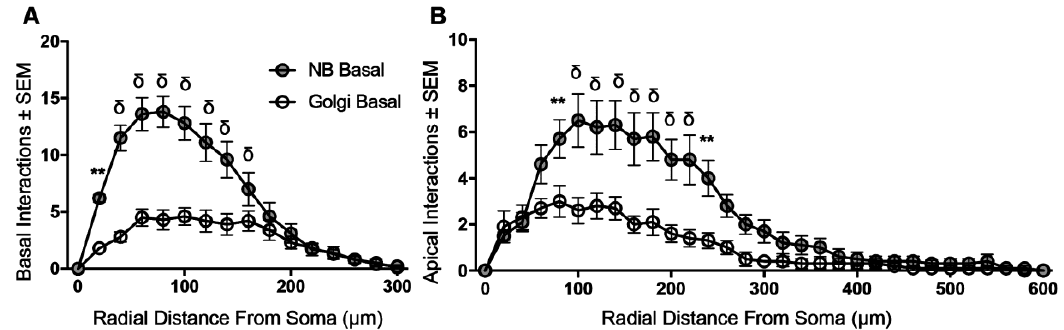
Figure 4. Sholl analysis shows increased dendritic branching in BLA principal dendritic arbors from NB-filled neurons compared to Golgi–Cox-stained neurons. ( A , B ) show Sholl analysis of increased dendritic branching in NB-filled (grey circles) neurons compared to Golgi–Cox impregnated neurons (open circles) in basal (method: **** p < 0.0001) and apical (method: **** p < 0.0001) arbors respectively. Two-way ANOVAs with Bonferroni post-tests, ** p < 0.01, and δ **** p < 0.0001.